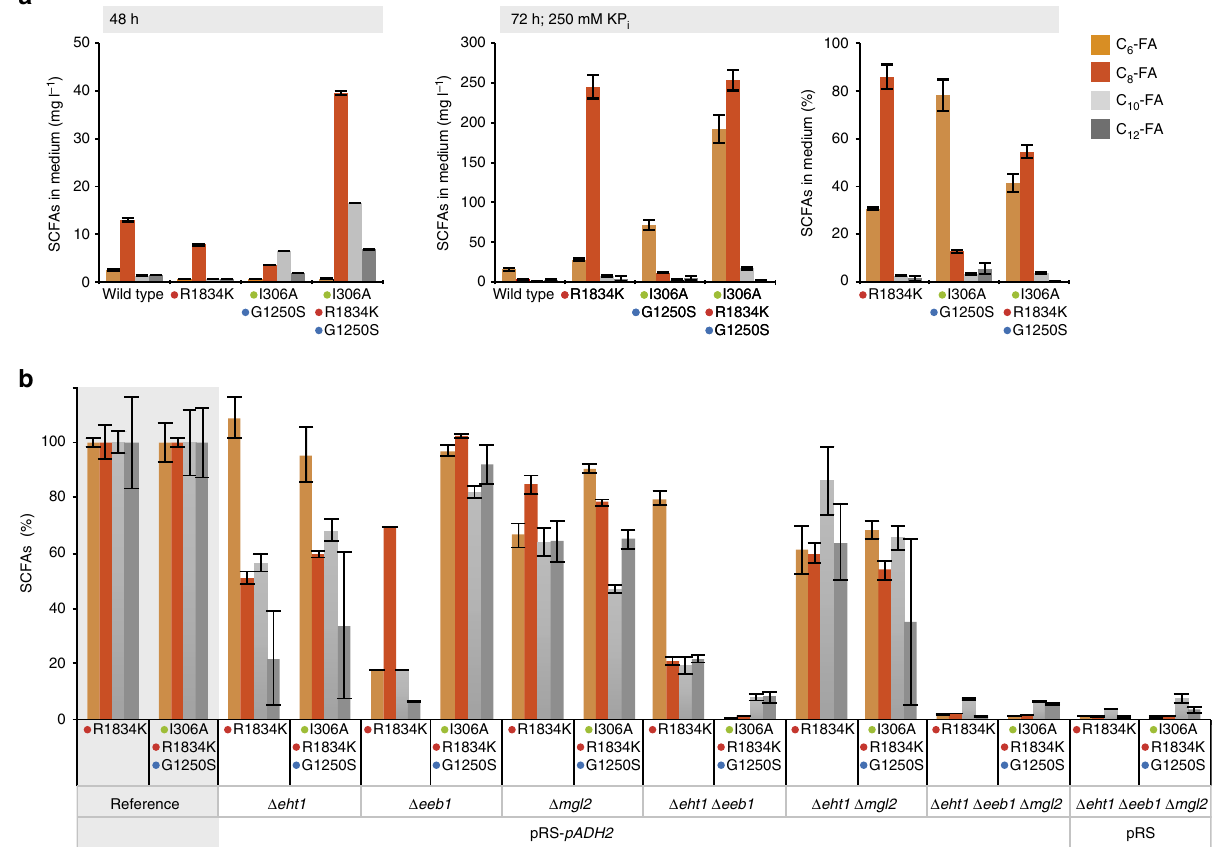
Figure 3 | SCFA levels in FAS overproducing strains and AEATase knockout strains. ( a ) Product spectra of S. cerevisiae D fas1 D fas2 complemented with selected FAS expressed from pADH2 promoter-controlled genes. Expression conditions as described in Fig. 2b, with cultures grown for 48h in non-buffered and 72h in buffered medium (250mM potassium phosphate, KP i ). Experiments were performed with statistics as described in Fig. 2b. For cultures grown for 72h, product distribution is also given in shares of total yields. ( b ) Percentage of extracellular FAs detected in medium in AEATase knockout strains. All AEATase knockout strains are also deficient in FAS ( D fas1 D fas2 ; not indicated by figure labels). Strains are complemented with SCFA producing FAS mutants, as indicated, with genes under control of the wild type and the pADH2 promoter. Recorded extracellular SCFA concentrations are given in percentage and relate to reference ( D fas1 D fas2 ), which is set to 100% (grey background). Cultivation was performed for 72h in 100mM buffered phosphate medium. Experiments were performed with statistics as described in Fig.